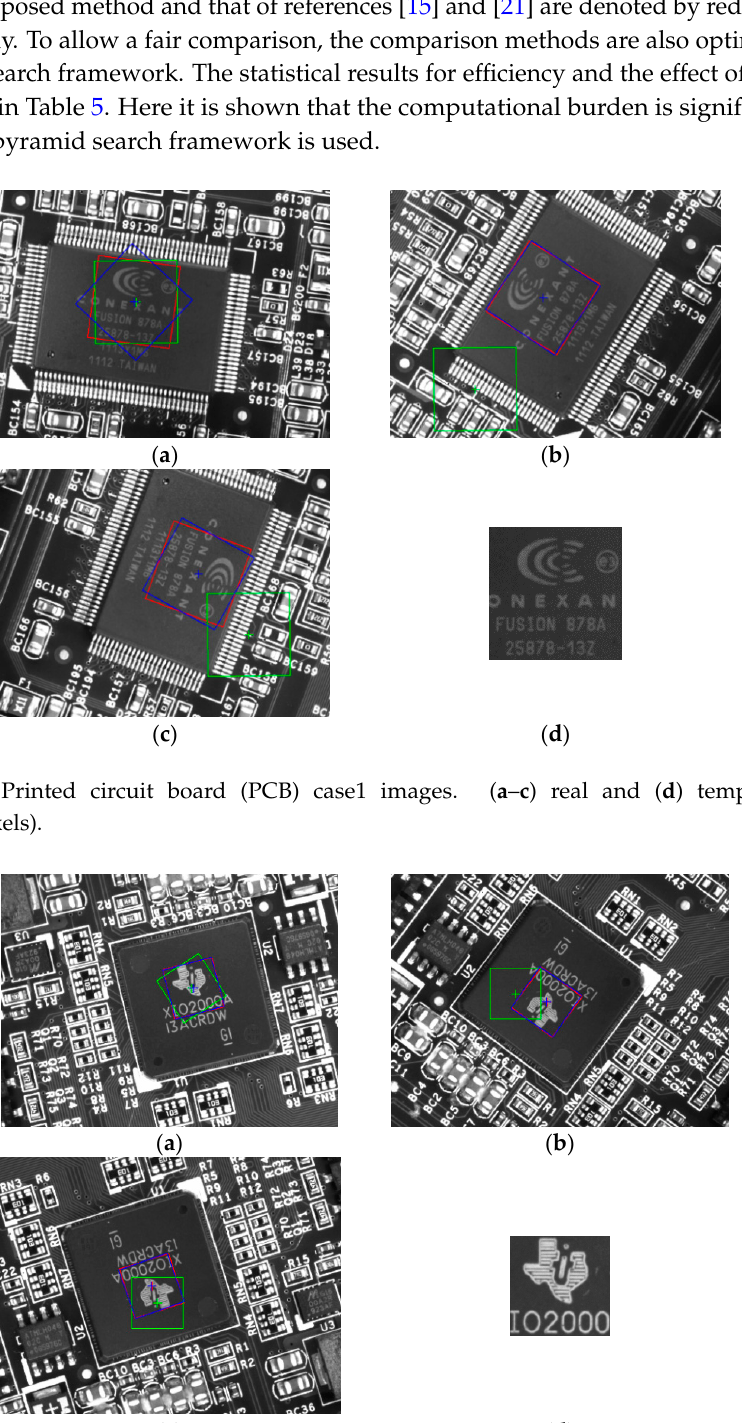
Figure 17. PCB case2 images. ( a – c ) real images and ( d ) template image (200 × 200 pixels).